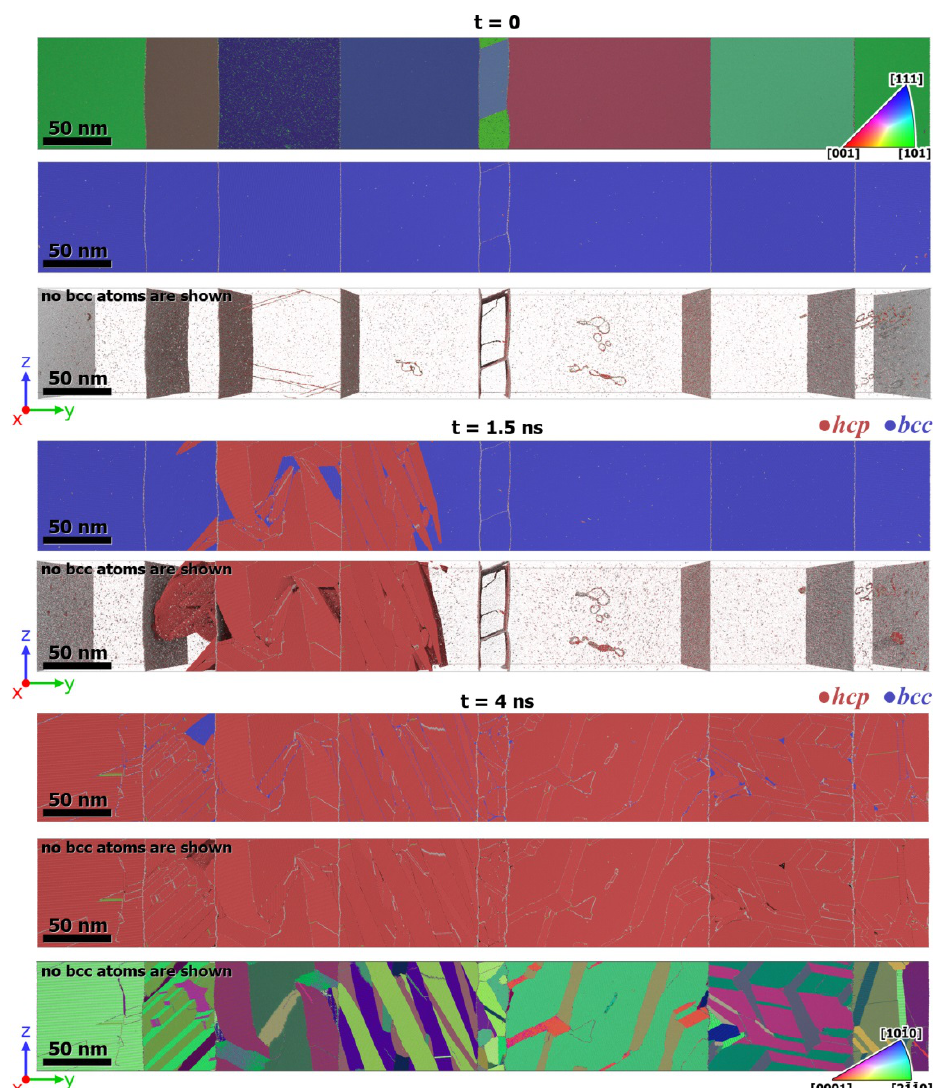
Fig. 1. Destruction of the metastable β phase (β→α martensitic transition) in a bamboo-like coarse grain sample during cooling from T =600 K down to room